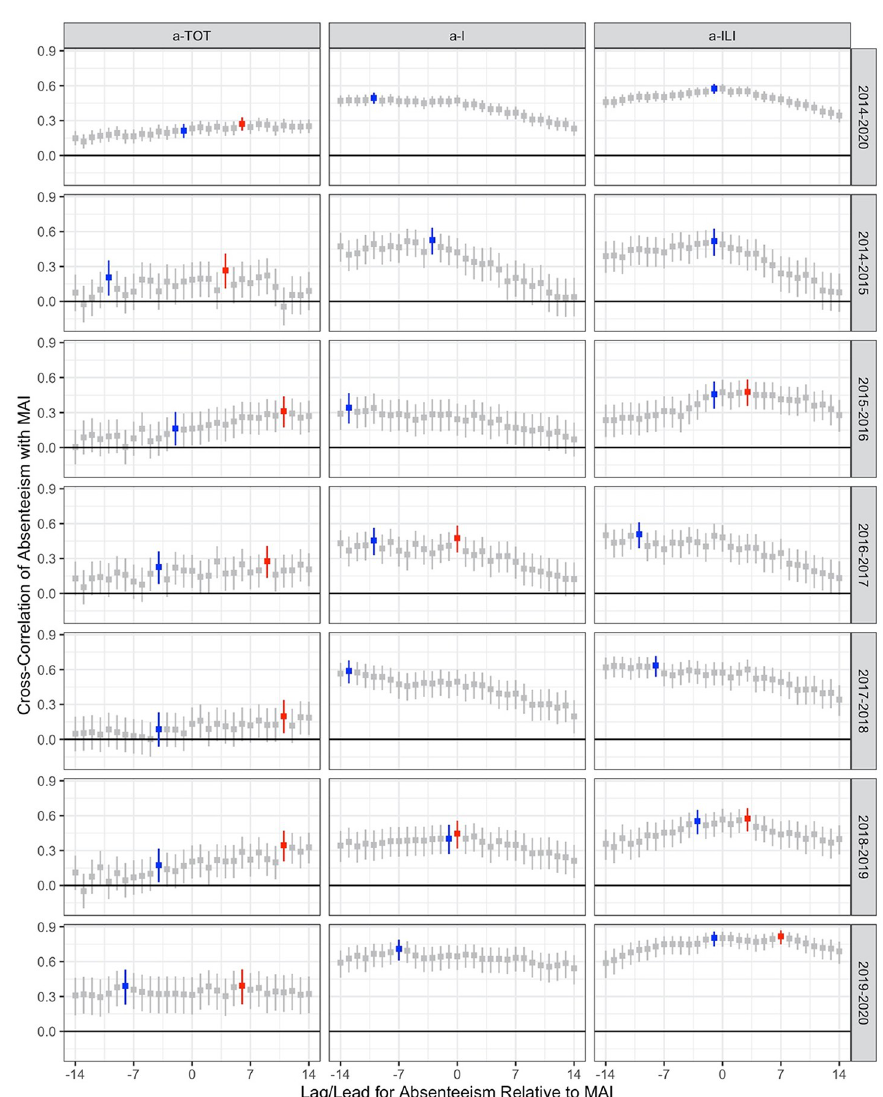
Fig 5. Cross-correlation functions (estimate and 95% confidence interval) for square-root daily absenteeism counts and square-root medically-attended influenza (MAI) counts for all six school years/influenza seasons combined (top row) and for each school year/influenza season. Results are shown for total absenteeism (a-TOT; first column), absenteeism due to illness (a-I; second column) and absenteeism due to influenza-like illness (a-ILI; third column). Negative lag/lead indicates absenteeism preceding MAI, while positive lag/lead indicates MAI preceding absenteeism. The maximal correlation for absenteeism preceding MAI is highlighted in blue; if different, the maximum correlation over the entire time frame (-14 days to +14 days) is highlighted in